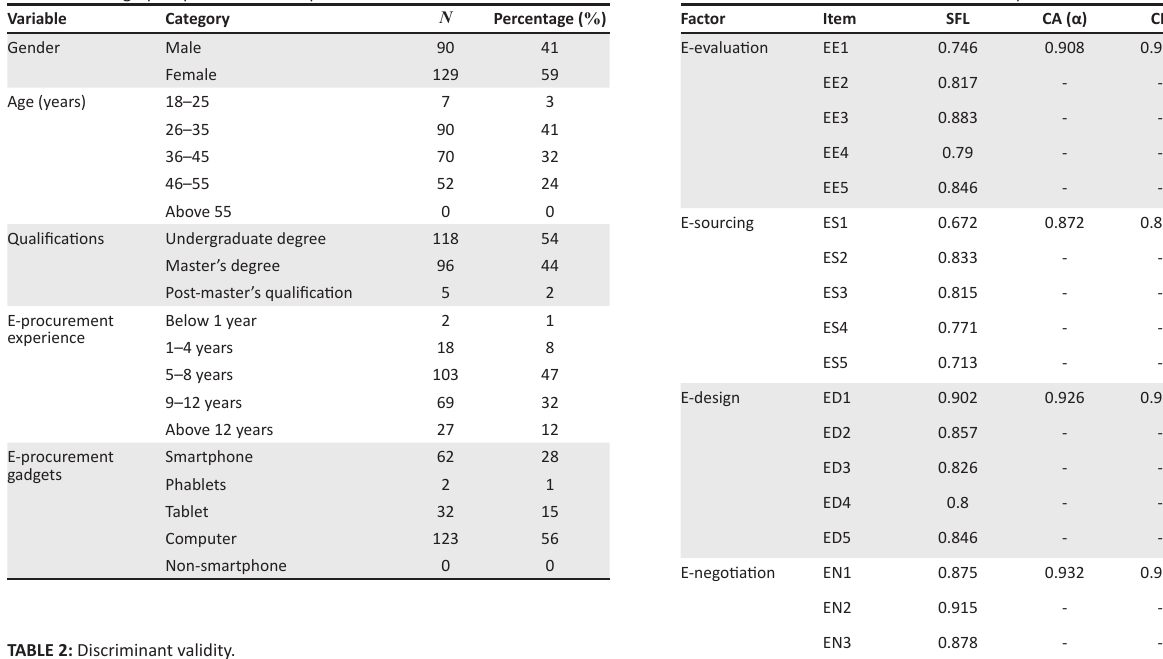
TABLE 2: Discriminant validity. Factor